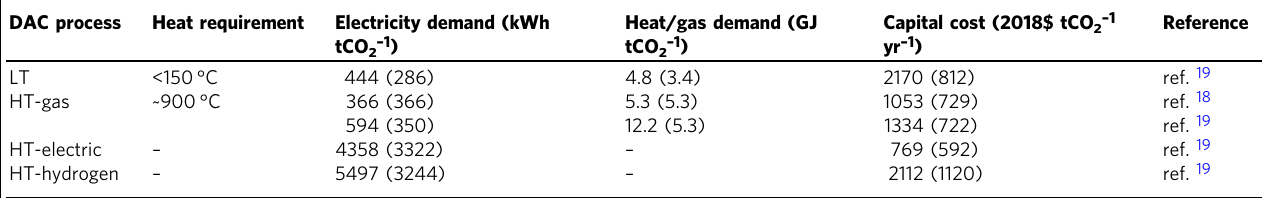
Table 1 Initial ( fl oor) assumptions for energy demand and cost of DAC processes considered in this